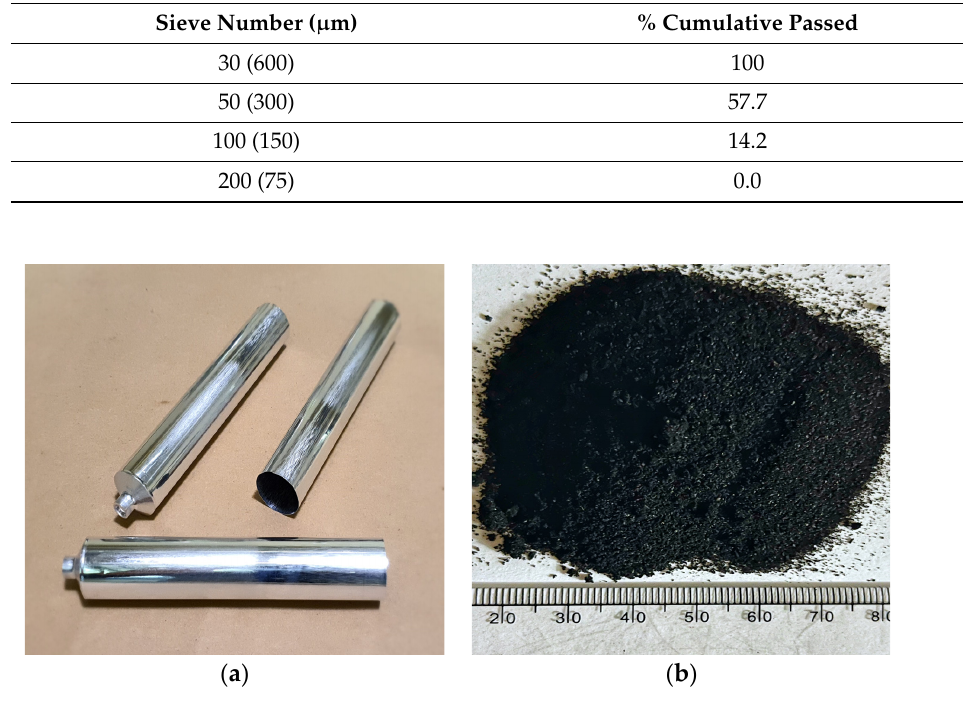
Figure 3. Aluminum tube ( a ) and crumb rubber ( b ). Table 1. Properties of base asphalt binder (PG 64–22).